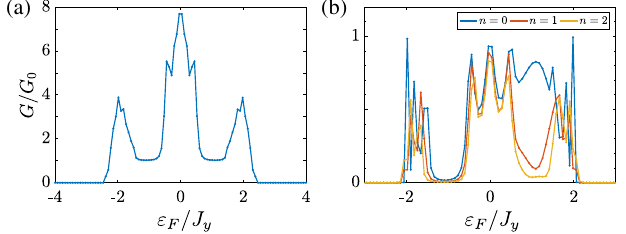
FIG. 9. Two-terminal conductance of the complete shaken- channel model defined in Eq. (8), as obtained from the Floquet 11 , N 12 , φ ¼ 2 π = 3 , RGF method. Parameters are λ y ¼ cut ¼ J 4 J κ ¼ 0 . 03 ω =l n 11 . (a) The conductance is y ¼ 1 , H , and F ¼ obtained from the complete Floquet sum rule in Eq. (11); (b) individual contributions to the conductance corresponding to n ¼ 0 (blue), n ¼ 1 (orange), and n ¼ 2 (green). The main contribution to the plateau at E F > 0 stems from the n ¼ 0